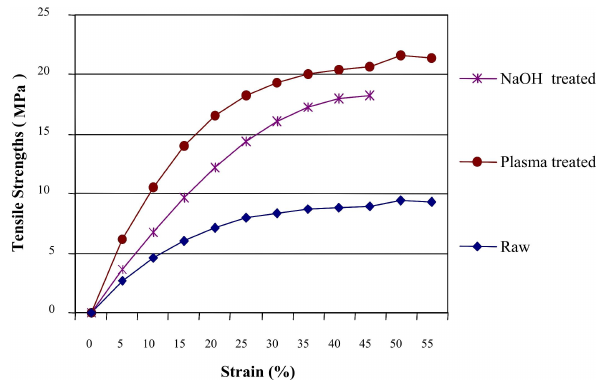
Figure 13: Comparison of tensile strength of untreated and NaOH and plasma treated RH [62]